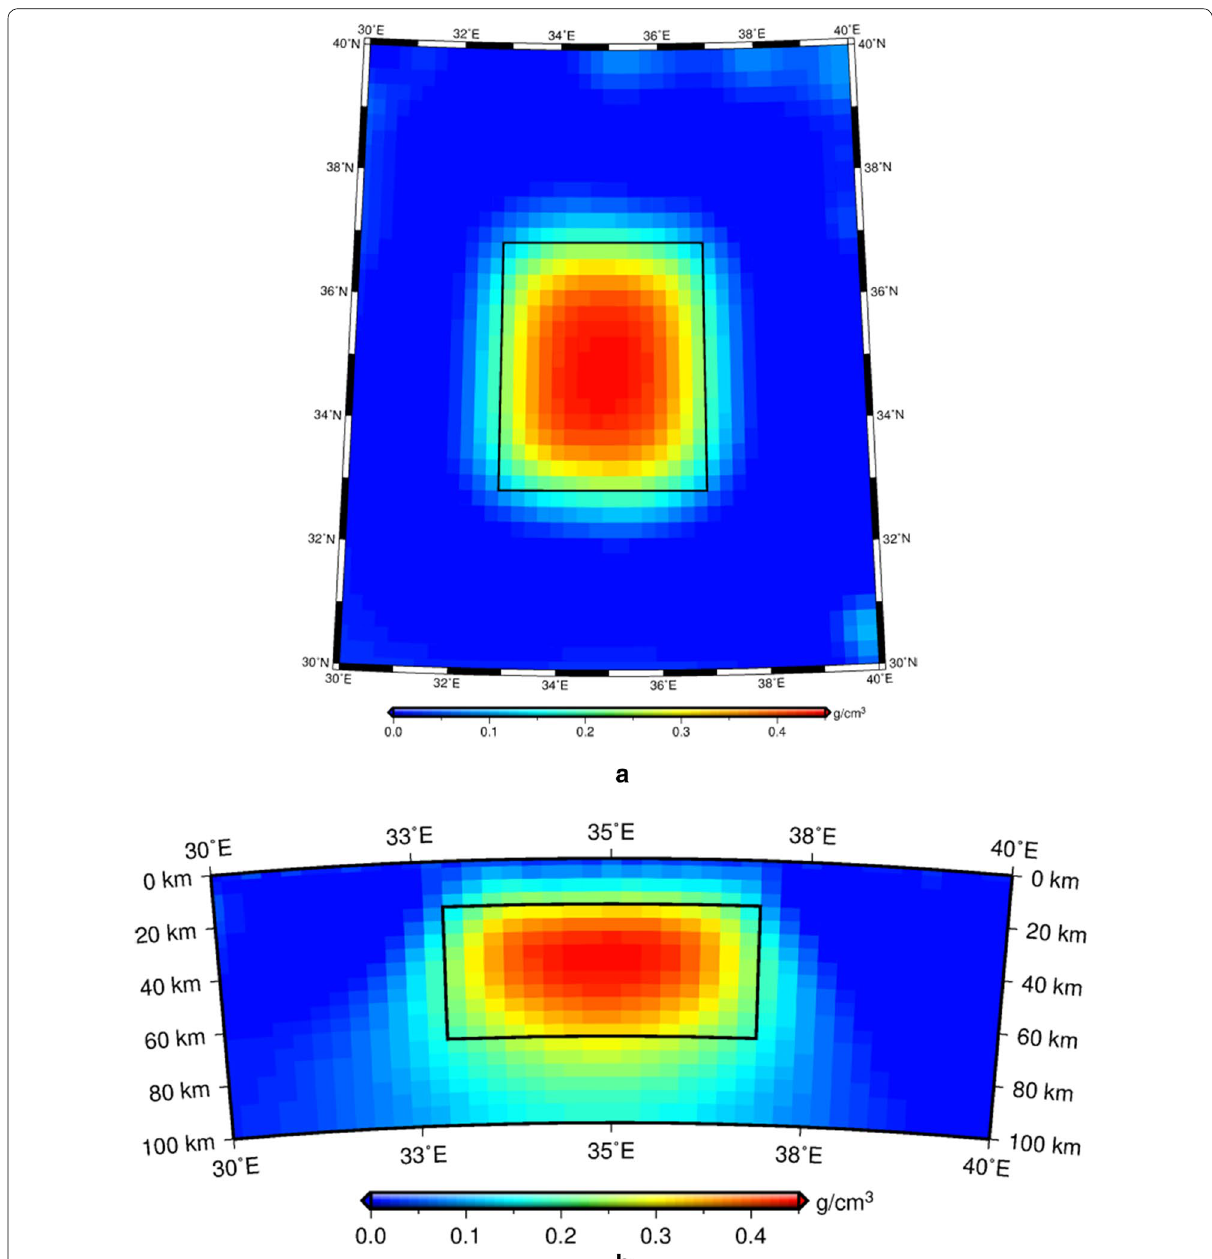
Fig. 7 Recovered density distribution for single model. a Horizontal slice of the recovered model with a radial length of 1698 km, b vertical profile of the recovered model at the latitude of